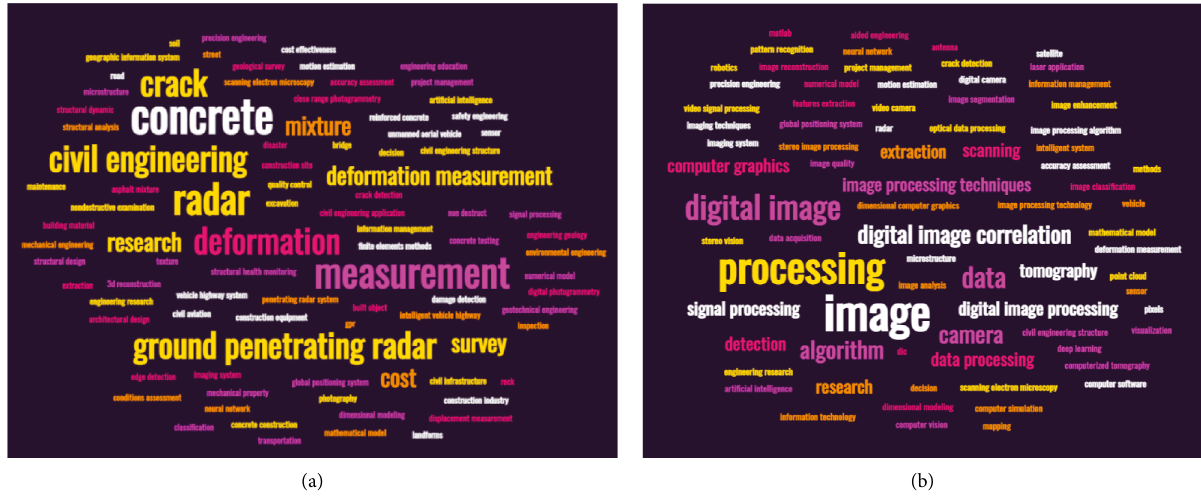
Figure 8: (a) Key points related to civil engineering. (b) Key points related to image